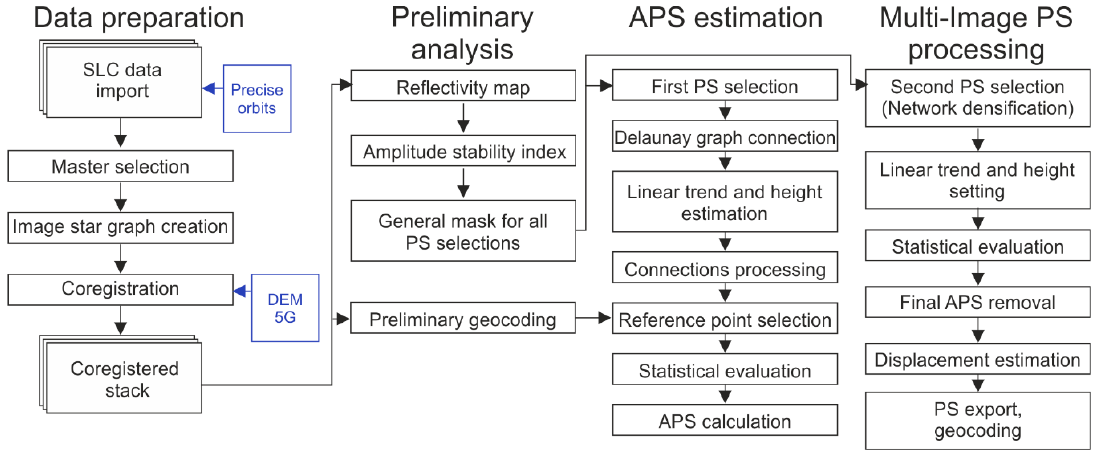
Figure 5. Simplified workflow of PSI Processing in SARPROZ.